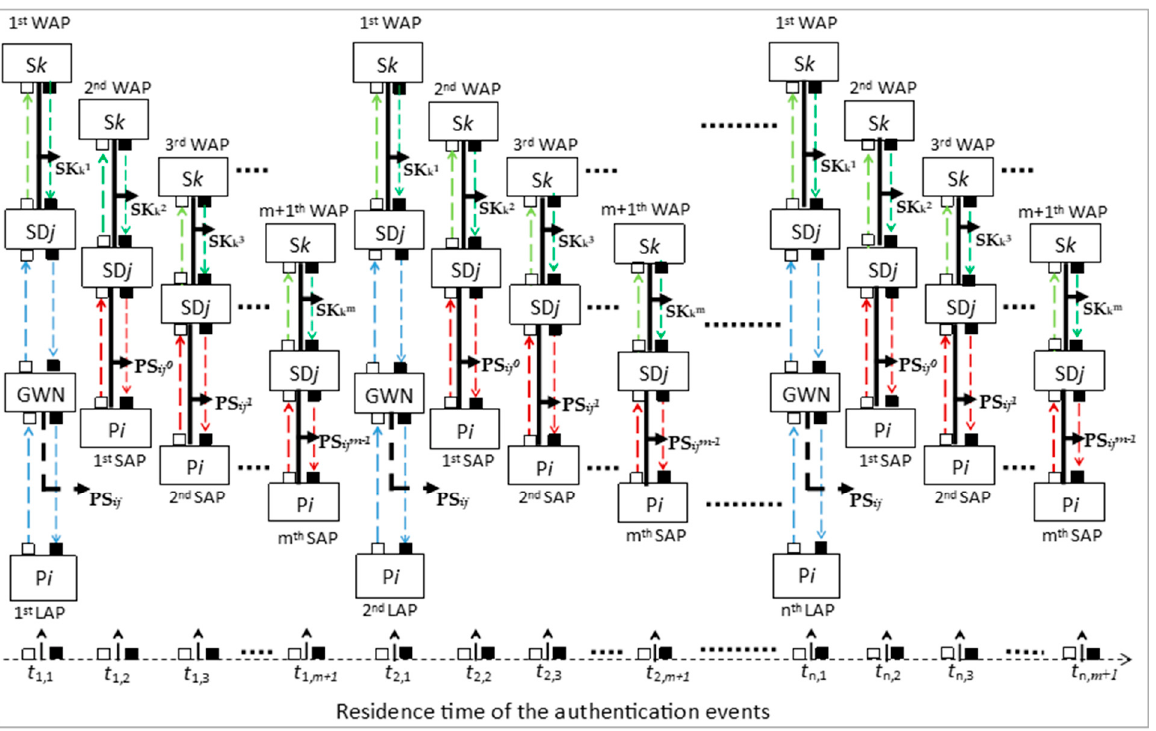
Figure 5. The E2EA scheme residence timeline diagram: the dashed blue arrows represent the request and response authentication messages of the LAP; the dashed red arrows represent the request and response authentication messages of the SAP; the dashed green arrows represent the request and response authentication messages of the LAP; the dashed black arrows represent the generation process of the PS ij key; and the solid black arrows represent the derivate process of subsequent PS ij and SK k keys.